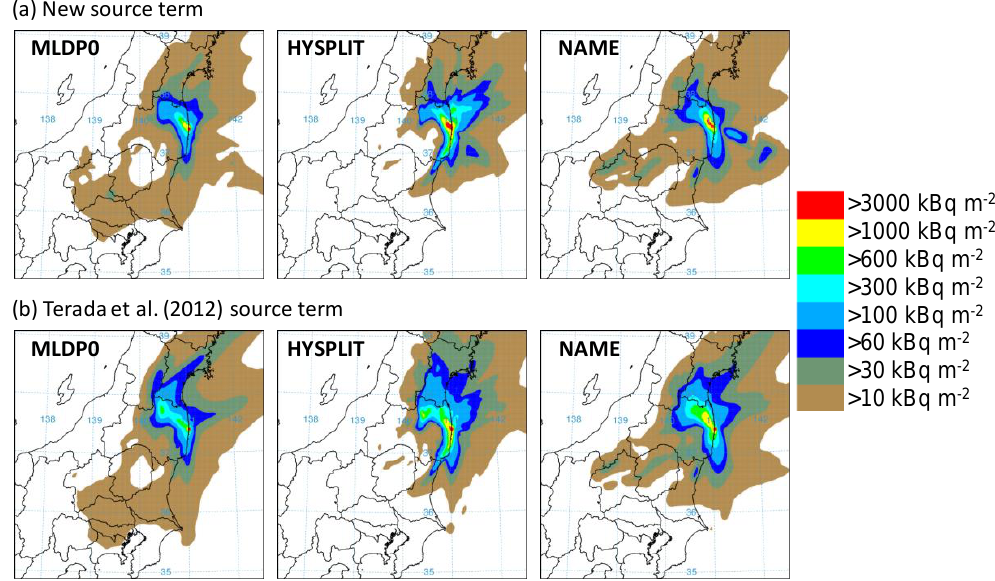
Figure 18. Spatial distributions of surface depositions of 137 Cs (kBqm − 2 ) on 1 April 2011 calculated by three WMO models (MLDP0, HYSPLIT, and NAME) using (a) the new source term and (b) Terada et al.